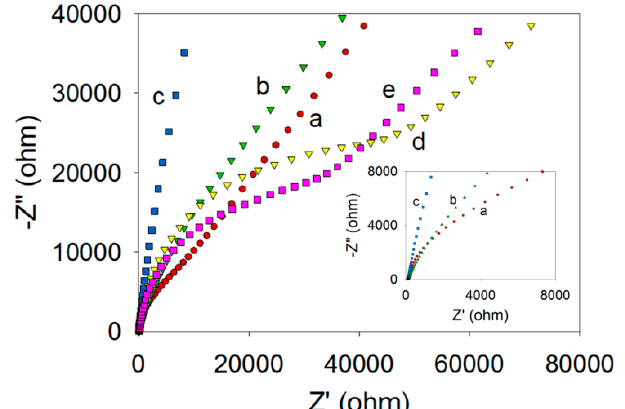
Figure 2. Nyquist plots of (a) GCE, (b) Nafion/GCE, (c) BCNPs/Nafion/GCE, (d) Tyr/Nafion/GCE, (e) BCNPs/Tyr/Nafion/GCE in 5 mM K 3 Fe (CN) 6 containing 0.1 M KCl.